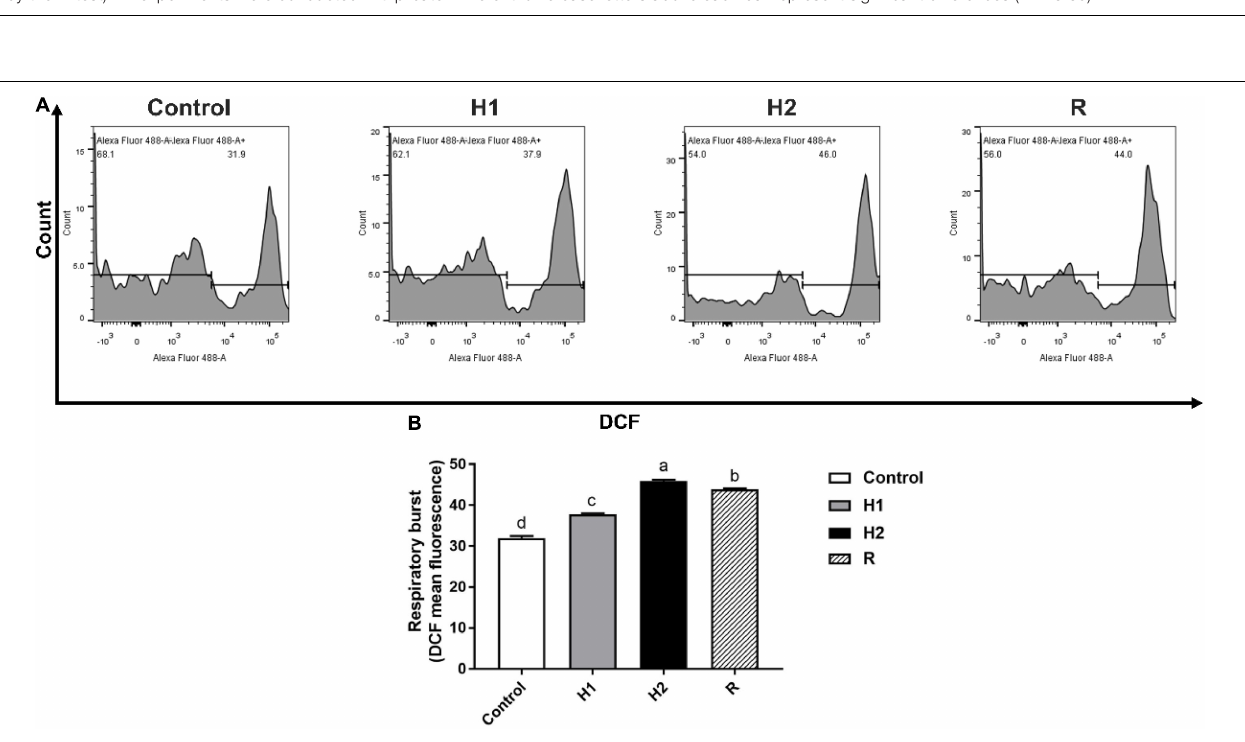
FIGURE 5 | The change of respiratory burst in the blood cell of largemouth bass under acute hypoxia and reoxygenation. (A) The respiratory burst of blood cell was determined by flow cytometry. (B) The respiratory burst for each cell treatment. Data are expressed as the mean ± SD ( n = 3; one-way analysis of variance followed by the T -test). All experiments were conducted in triplicate. Different lowercase letters above each bar represent significant differences ( P < 0.05).